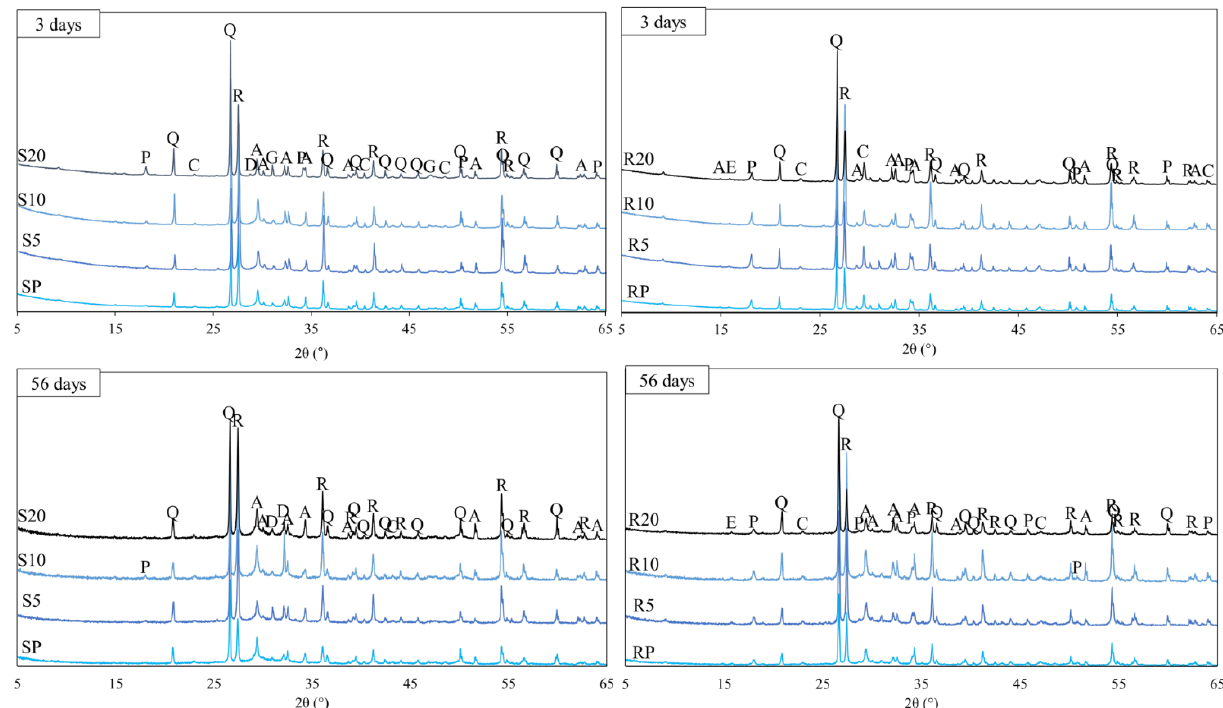
Figure 5. XRD patterns of samples at the ages of 3 and 56 d (A: alite, C: calcite, D: dipotassium sulfate, E: ettringite, G: gypsum, P: portlandite, Q: quartz, and R: rutile).